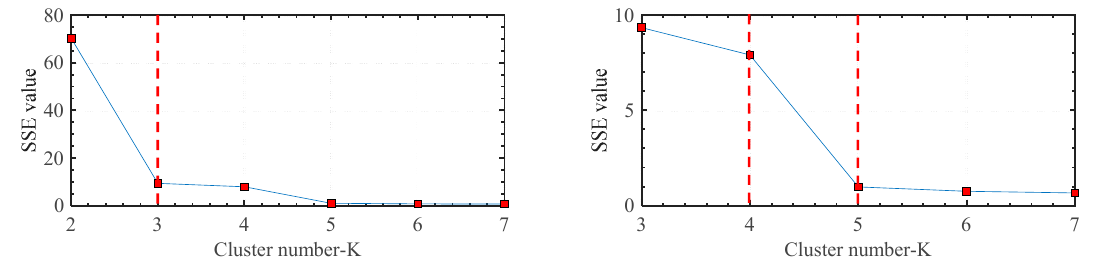
Figure 8. Sum value of the total squared errors ( SSE ) of K-means classification with different K values.